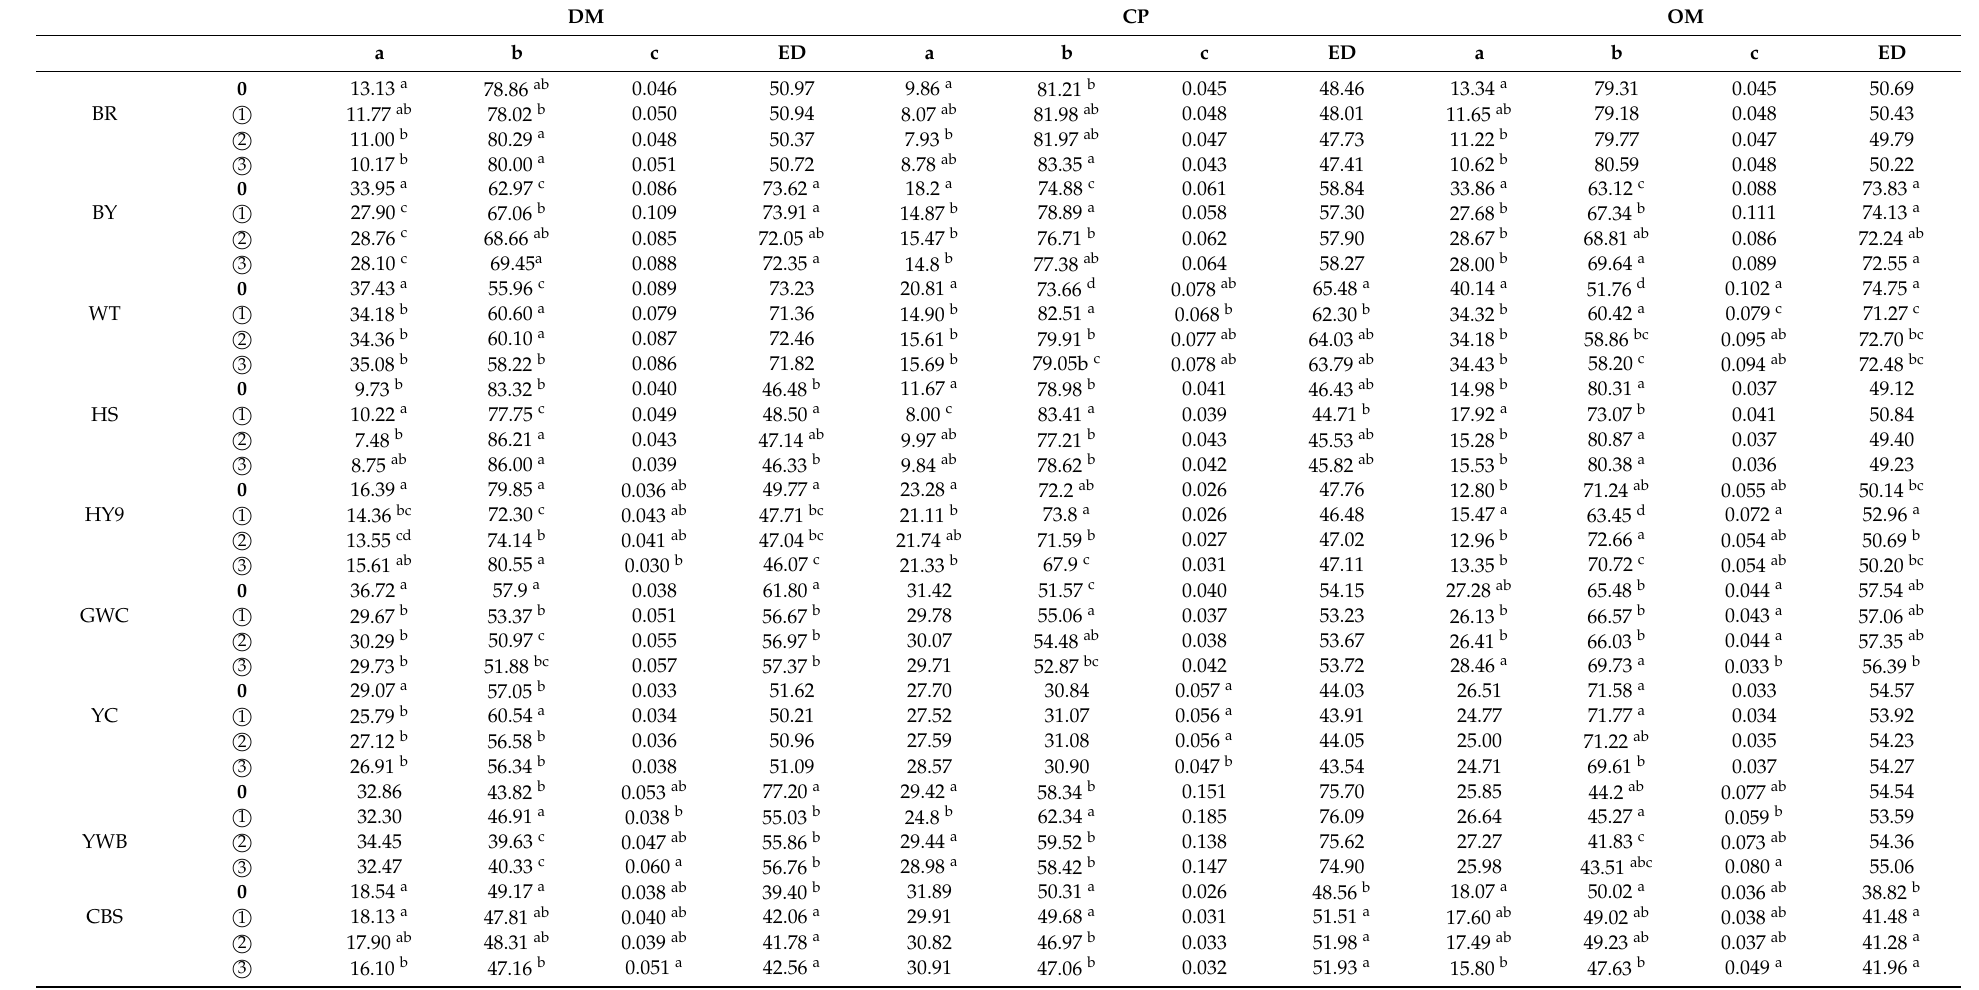
Table 4. The degradation parameters of dry matter, crude protein, and organic matter in rumen of nine energy feeds